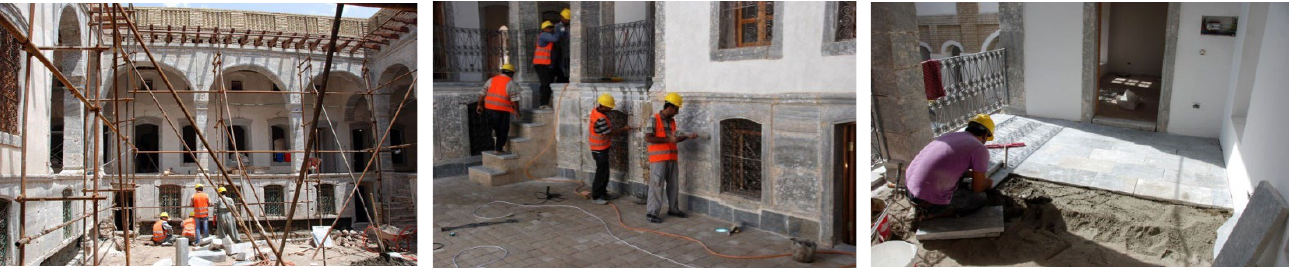
Figure 11. Percentages of adaptation projects in the Erbil Citadel and the buffer zone.